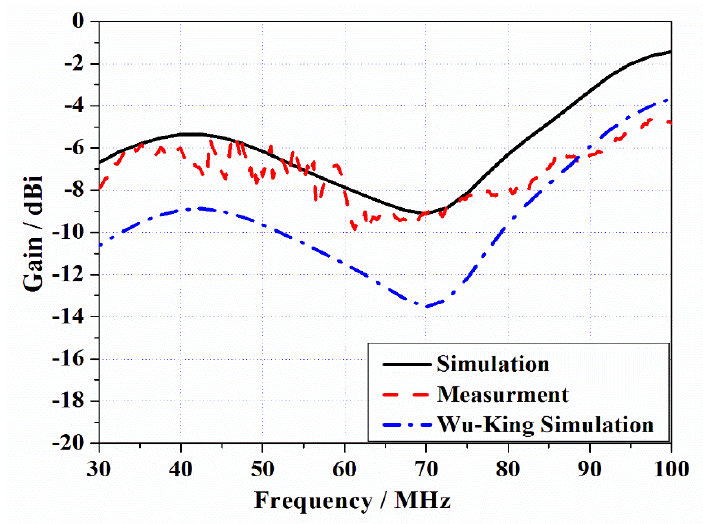
Figure 10. Comparison of realized gains between simulation and measurement.